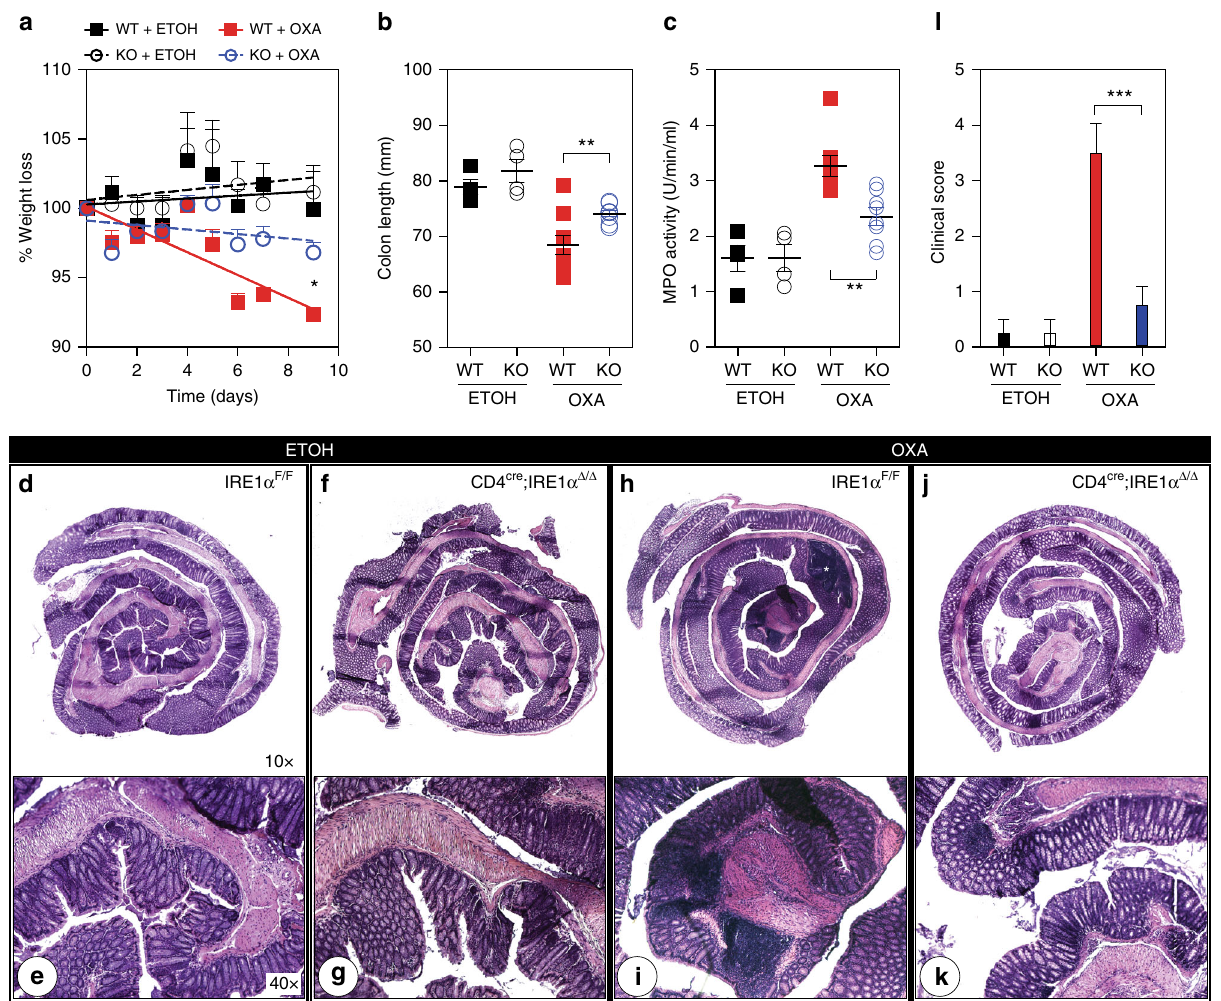
Fig. 6 Deletion of IRE1 α within iNKT cells protects mice from oxazolone colitis. IRE1 α F/F control ( n = 10) and CD4 cre ;IRE1 α Δ / Δ ( n = 10) mice were presensitized with either ethanol (ETOH) or 3% oxazolone (OXA) and then challenged intrarectally with either ethanol or 1% oxazolone 7 days after intrarectal challenge. Weight loss ( a ), colon length ( b ), MPO activity ( c ) and clinical score ( l ) were subsequently evaluated for each group after the intrarectal challenge. Data represent mean values obtained from two independent experiments. d , f, h , j Photomicrographs (×10) of hematoxylin and eosin (H&E)-stained sections of whole intestine removed from ethanol or oxazolone-treated control ( d , h ) and CD4 cre ;IRE1 α Δ / Δ ( f , j ) mice 5 days after intrarectal challenge. e , g , i , k Photomicrographs (×40) represent boxed distal regions of 10× H&E-stained sections representative for each group. Asterisk indicates areas of mucosal erosion. Error bars show the mean ± s.e.m. Mixed model analysis was performed to assess differences in weight loss and * p < 0.05, ** p < 0.01, *** p < 0.001 determined by Mann – Whitney U